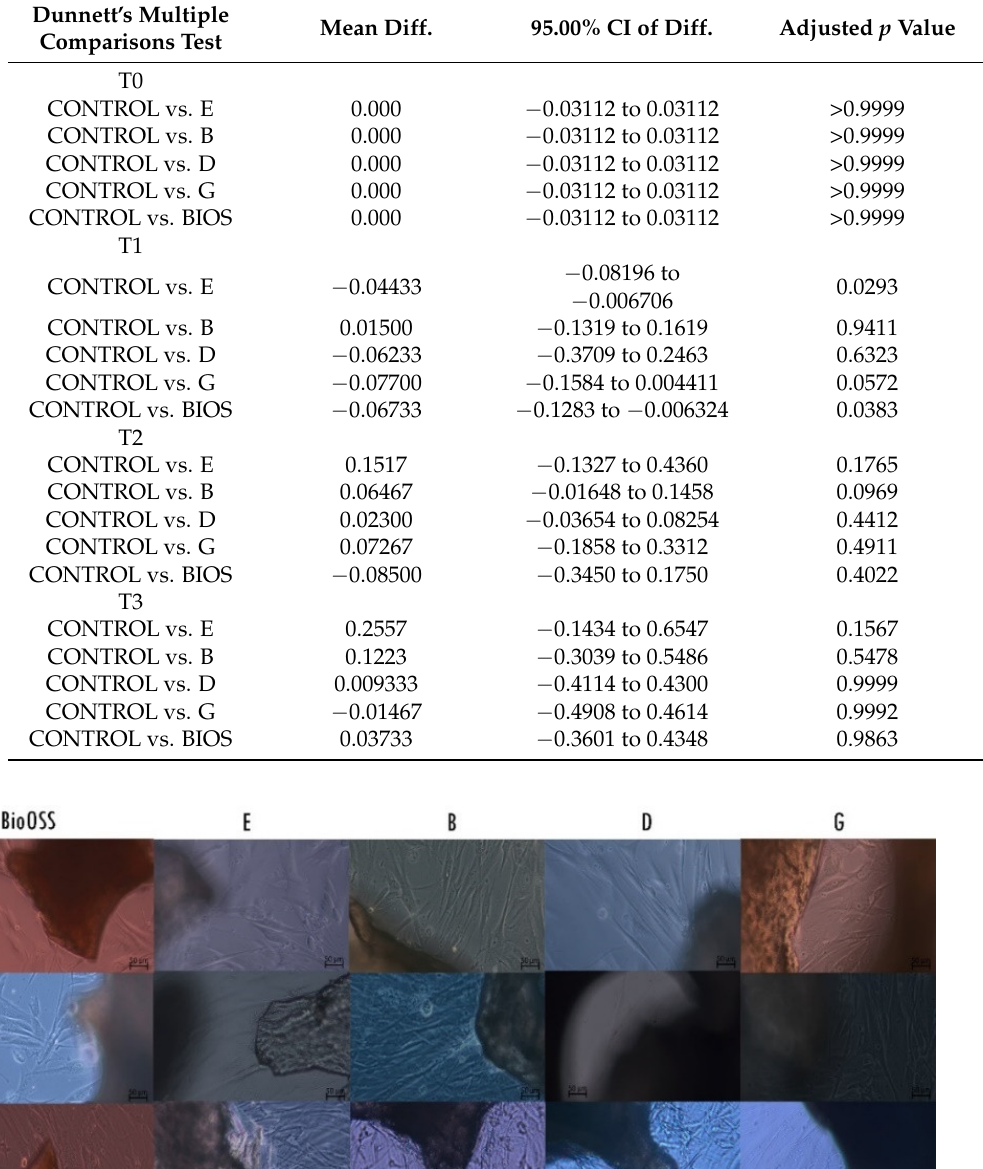
Table 1. Dunnett’s post hoc multiple comparison results.